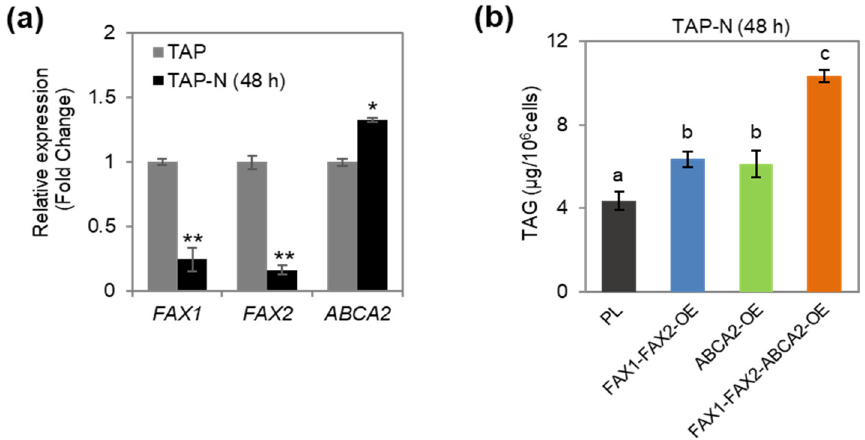
Figure 1. Oil content analysis of the cells under nitrogen-depleted conditions (TAP-N) for 48 h. ( a ) Quantitative RT-PCR (RT-qPCR) analysis of transcriptional responses of FAX1 , FAX2 , and ABCA2 to different nitrogen status in Chlamydomonas wild-type strain. The RT-qPCR results were normalized using the housekeeping gene RACK1 as the internal standard, and the fold changes of the relative expression levels were determined relative to normal conditions (TAP). Error bars represent standard errors based on four biological replicates. Statistical analysis was conducted using Student’s t test (* p ≤ 0.05; ** p ≤ 0.01). ( b ) TAG content in the transformants under TAP-N for 48 h. Data are based on Chen et al. 2022 [20]. PL, untransformed parental line. Statistically significant difference by Tukey’s HSD test was indicated by distinct letters.